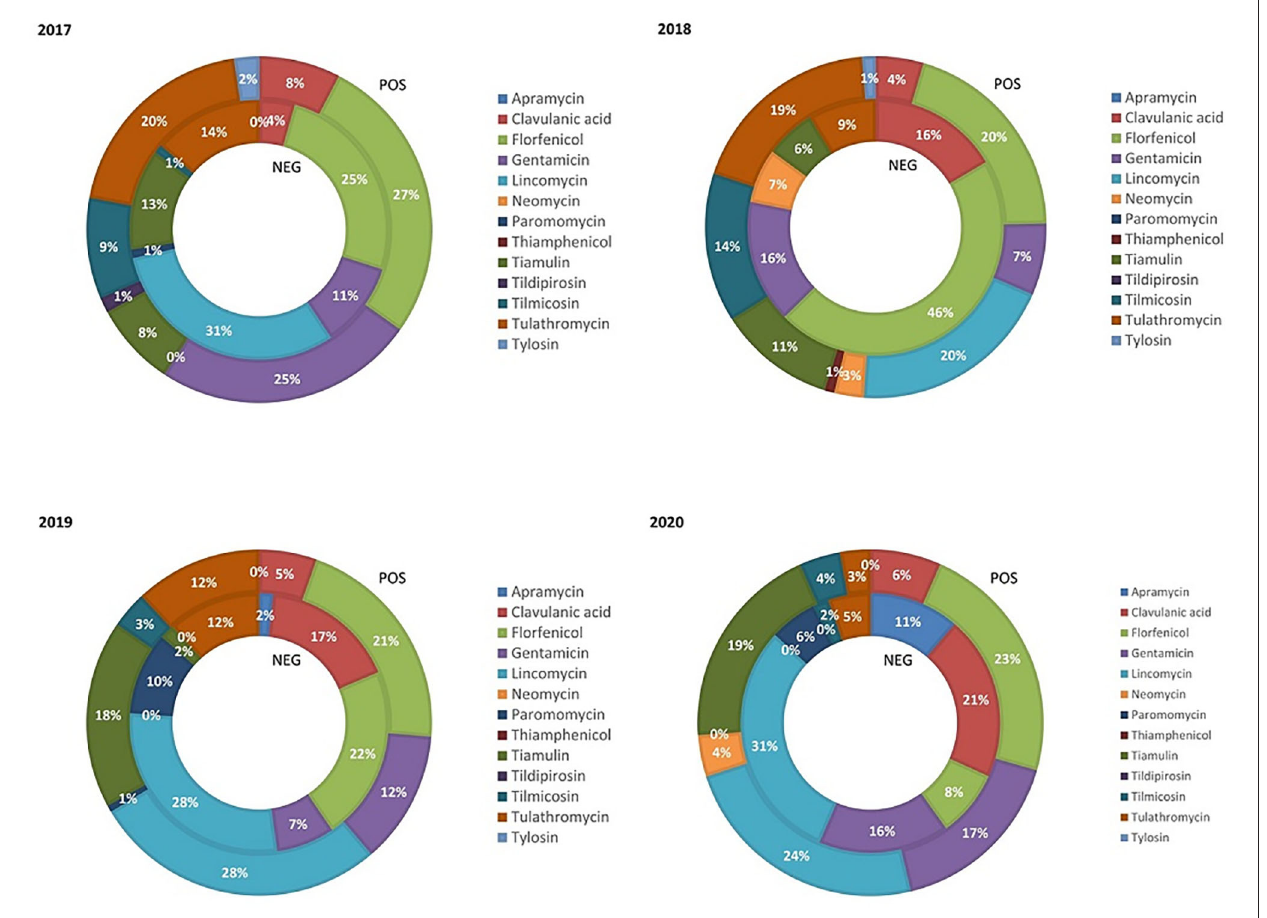
which both increased in the weaning period ( p < 0.0001 and p = 0.002, respectively). Nevertheless, the production phase did not affect the TLs, expressed as whole mortality. Finally,